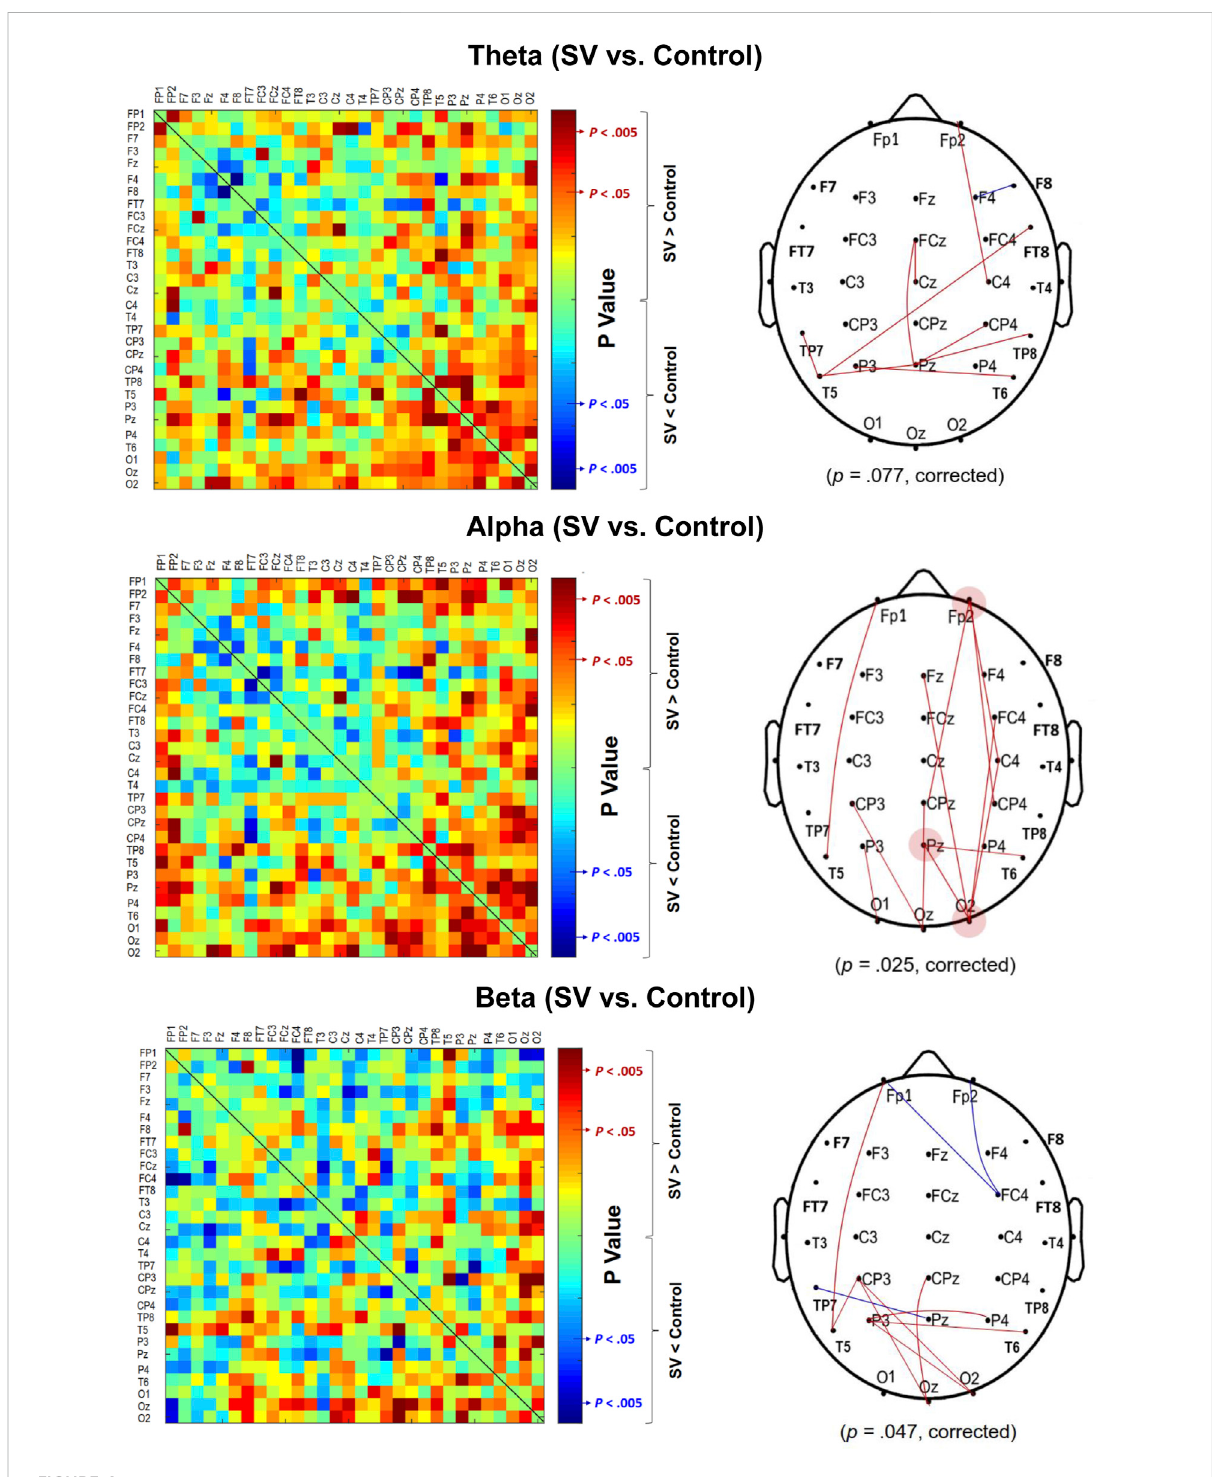
FIGURE 4 The phase-lag index (PLI) adjacent matrices represent the averaged strengths of inter-regional connectivity of the theta (4 – 7 Hz), alpha (8 – 12 Hz), and beta (13 – 35 Hz) bands between the SV and control